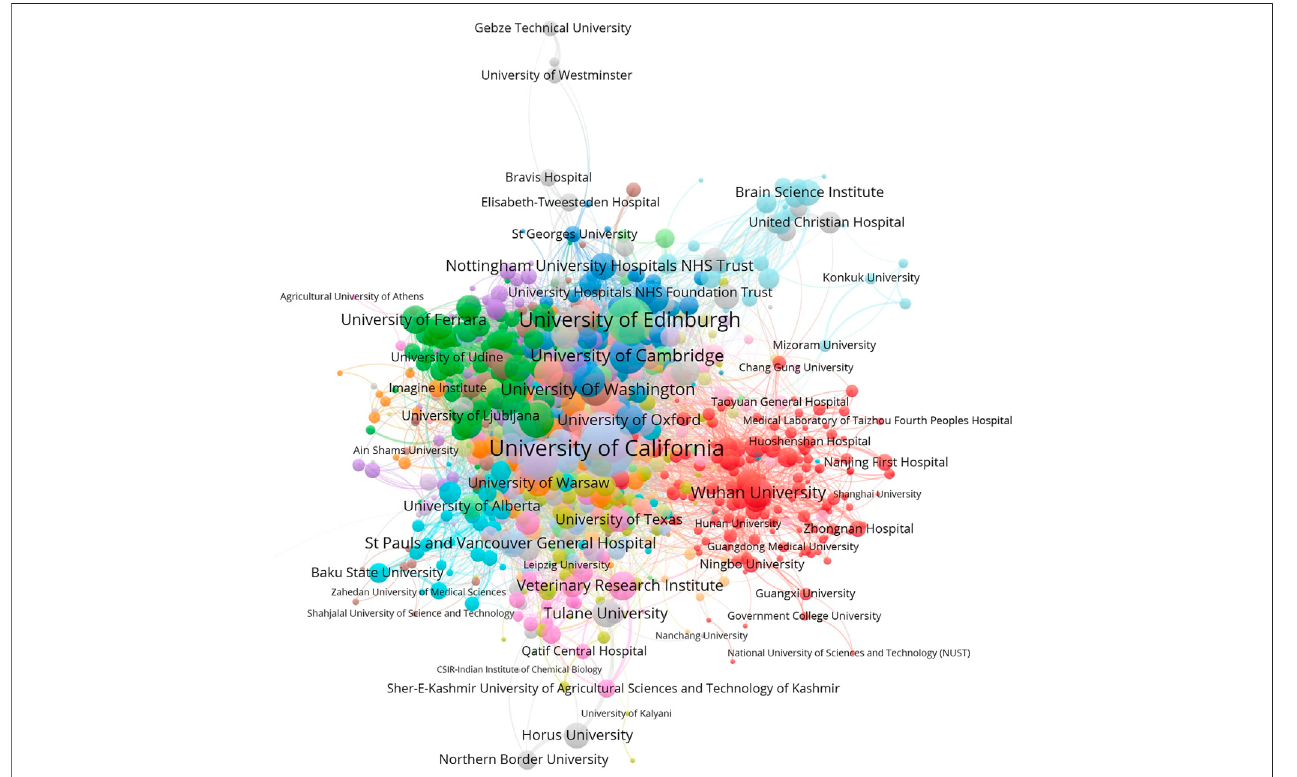
FIGURE 3 | The co-authorship network of research institutions (normalized by Jaccard Coef fi cient). 2